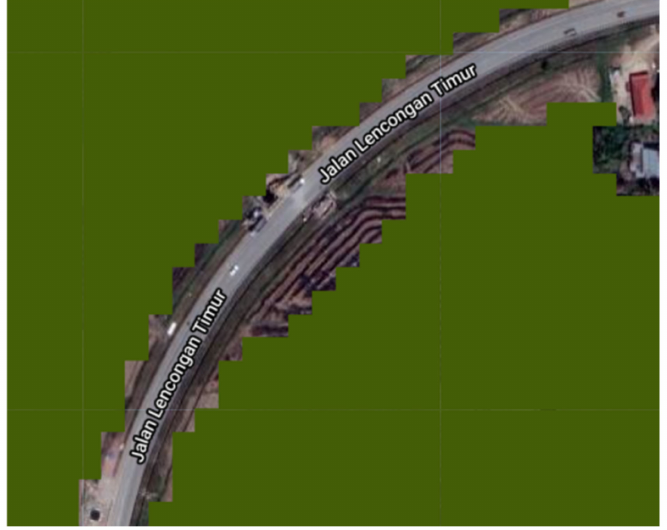
Figure 9. Sources of error in rice field classification. The green colour shows regions classified as rice field areas, while the rest were non-rice areas in Kedah State (6 ◦ 6 (cid:48) 41.10 (cid:48)(cid:48) N, 100 ◦ 22 (cid:48) 58.91 (cid:48)(cid:48)